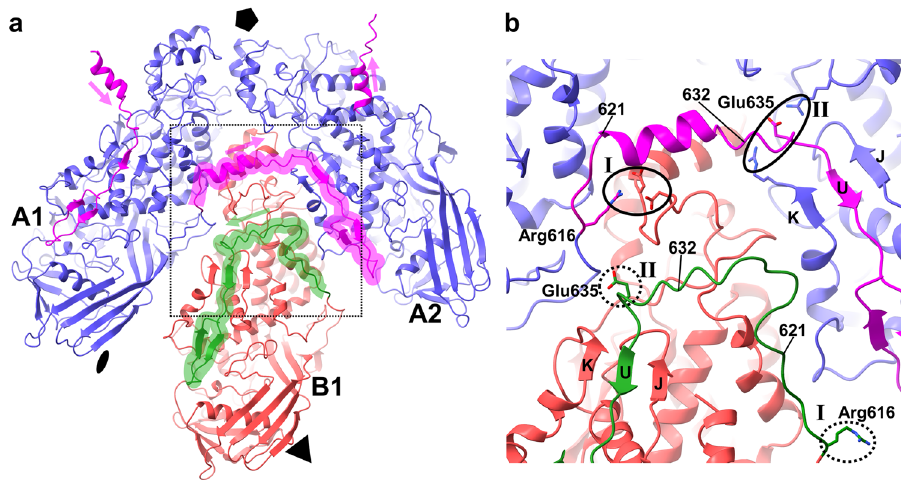
Fig. 5 Interactions in L-BC capsid are mediated by domain swapping between A but not B subunits. a Cartoon representation of L-BC icosahedral asymmetric unit and A subunit from a neighboring icosahedral asymmetric unit related by fi vefold rotation. The subunits are viewed from the inside of the particle. Subunits are distinguished by color: A in blue and B in red. The C-terminus of the A subunit, colored and highlighted in magenta, participates in domain swapping between adjacent A subunits. Domain swaps propagate around the fi vefold symmetry axis counterclockwise (magenta arrows). The C-terminus of the B subunit, colored and highlighted in green, remains within the bulk of the protein. b Detail of area outlined by dashed square in a . The domain swap between A subunits is stabilized by salt bridges at two positions denoted I and II and indicated with black ovals. Side chains of residues forming the salt bridges are shown in stick representation. The corresponding residues from the C-terminus of the B subunit are highlighted with dashed ovals and Roman numerals, however, they do not form salt